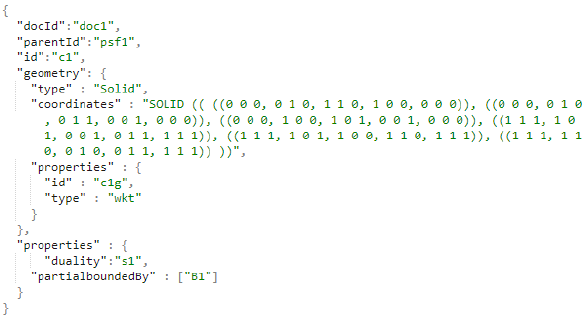
Figure 5. The JSON format for representing